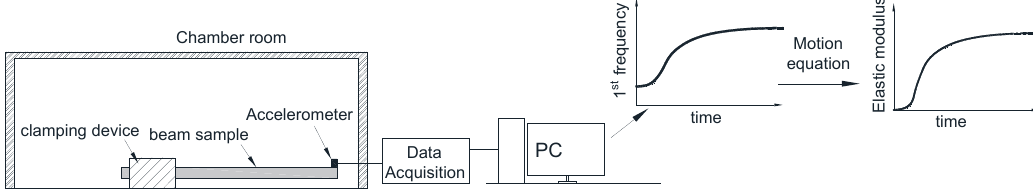
Figure 11. Experimental setup for the Elasticity Modulus Measurement through Ambient Response Method (EMM-ARM) testing of cement paste and data processing.